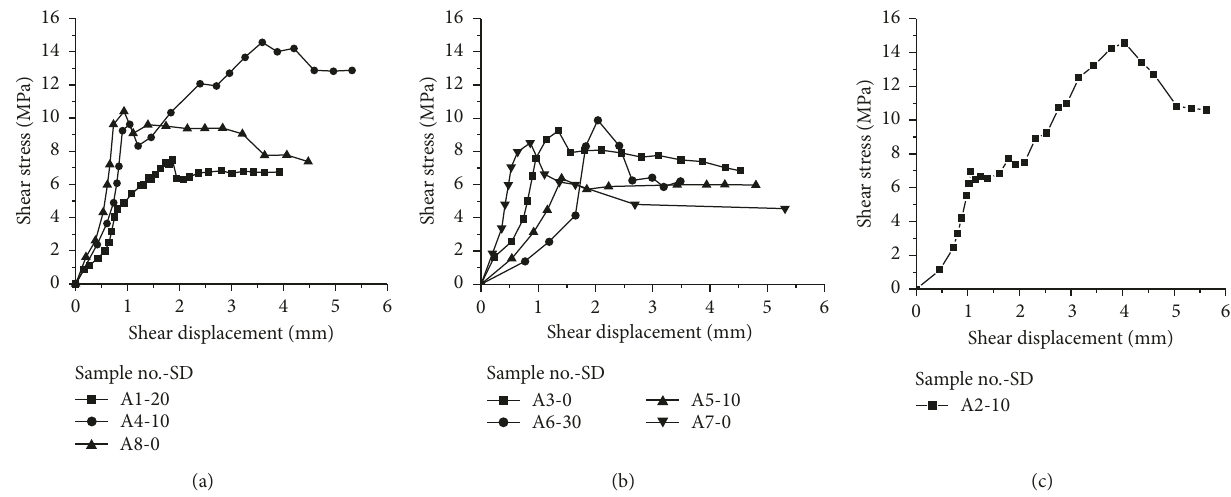
Figure 23: The curve of shear strengths and displacements of the original samples for the natural rough rock joint surface model. (a) NS 2.04; (b) NS 0.51; (c) NS 1.02. (cid:31) (cid:31) (cid:31) Table 3: Areas of natural rough rock joint surface models before and after the experiment. Area of the upper discontinuity (mm 2 Discontinuity